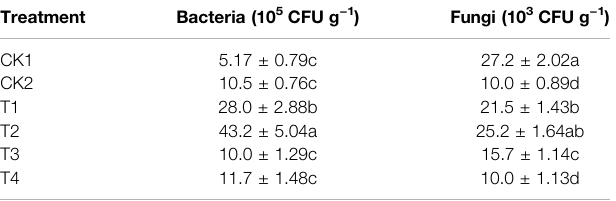
TABLE 2 | Effects of different treatments on the quantity of soil microorganisms. Treatment